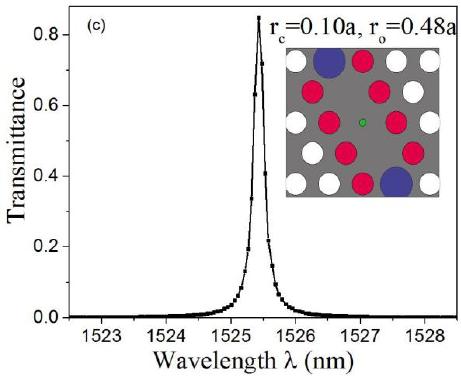
Figure 2. ( a ) Resonant wavelength and peak transmittance as functions of the radius of the center hole when r o = 0.32a; ( b ) the radius of the terminal hole when r c = 0.10a; ( c ) the transmission of the TE-like fundamental mode for r c = 0.10a and r o = 0.48a .